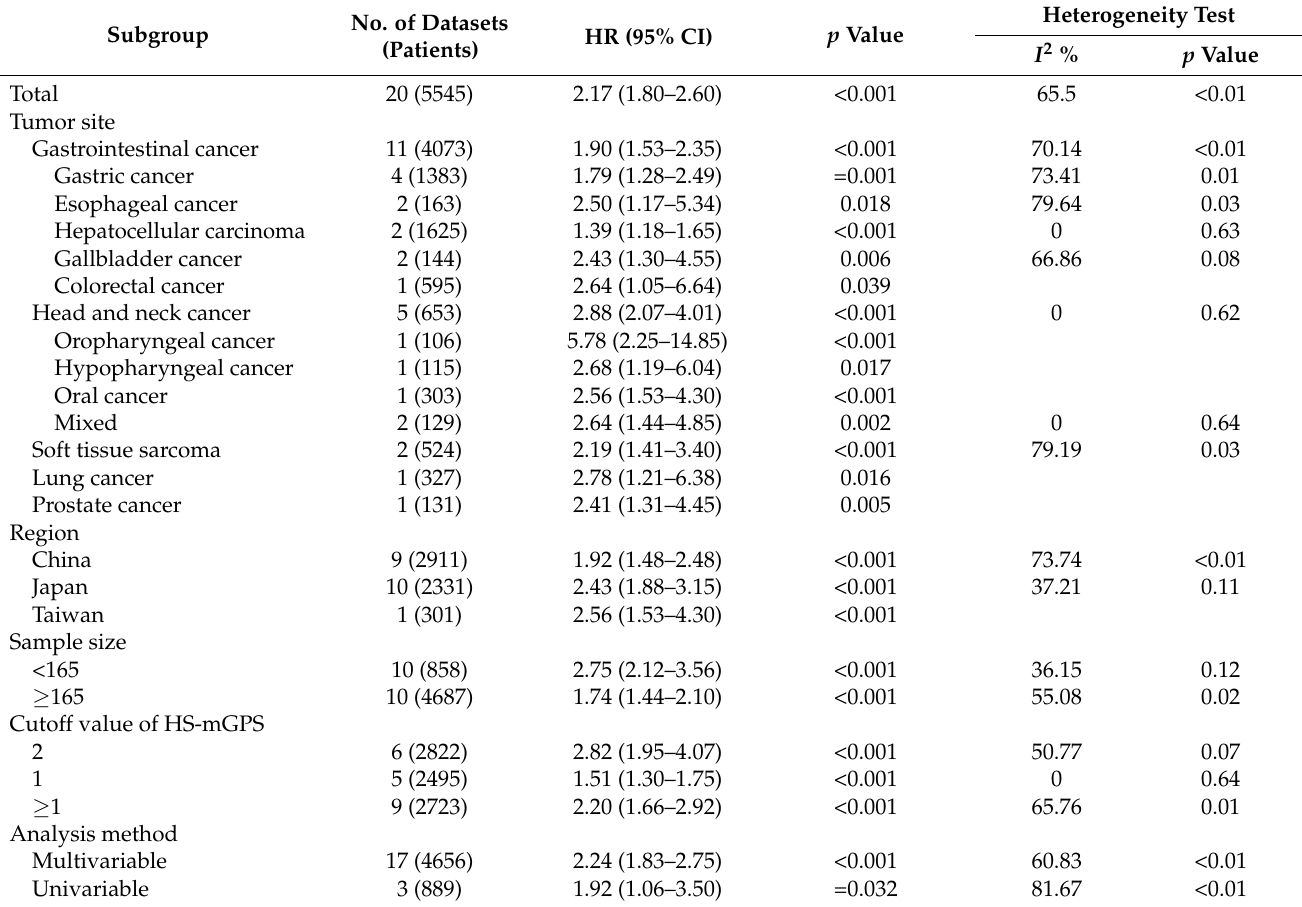
Table 2. Main results of stratified analyses for the impact of HS-mGPS on overall